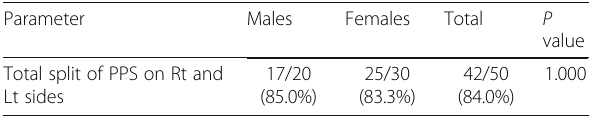
Table 3 Frequency of total split of pterygopalatine suture (PPS) between males and females Parameter